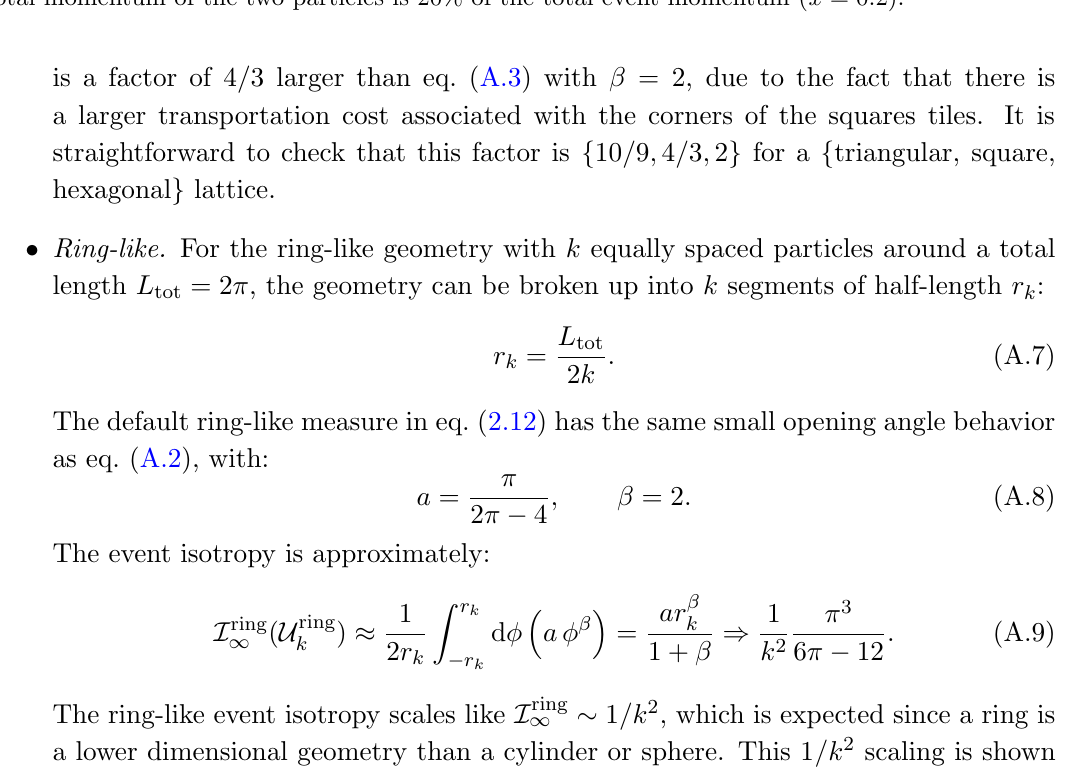
superimposed on a quasi-isotropic event U sph 2